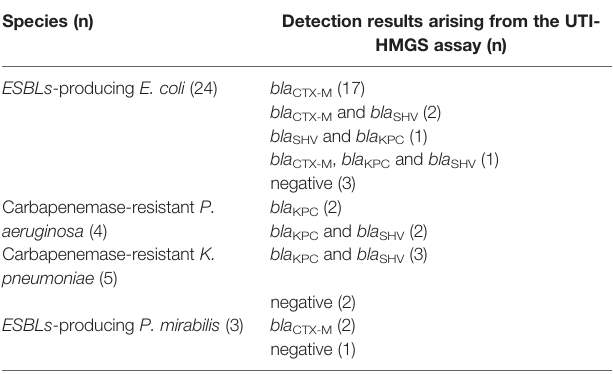
TABLE 3 | UTI-HMGS results for 36 positive urine samples that showed a drug- resistant phenotype. Species (n) Detection results arising from the UTI-